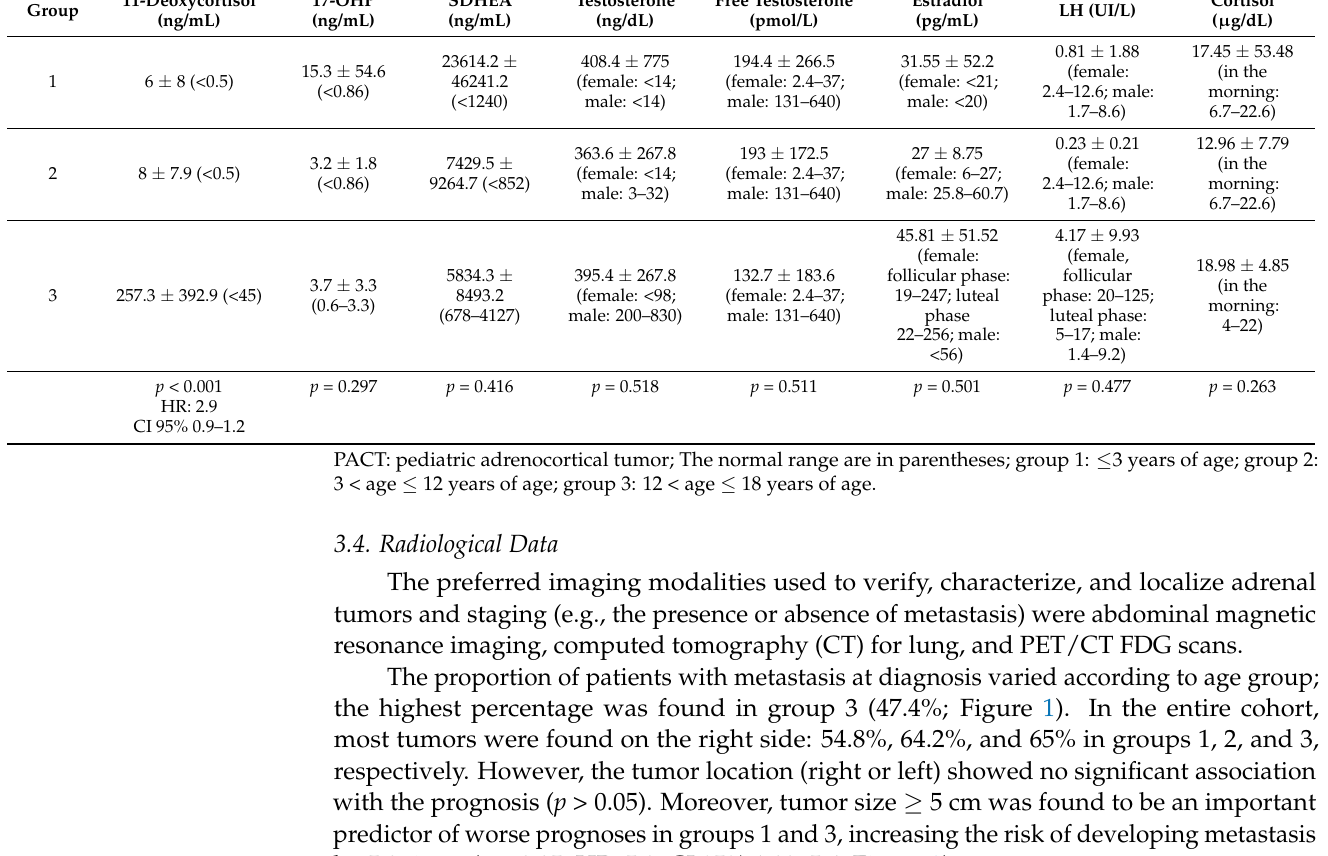
Table 2. Hormonal data of patients with PACTs from three age-groups.